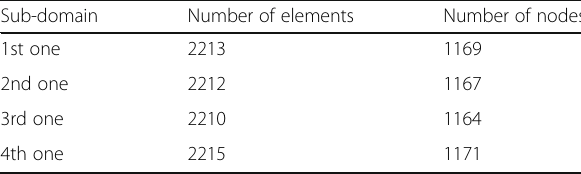
Table 1 Elements and nodes for four